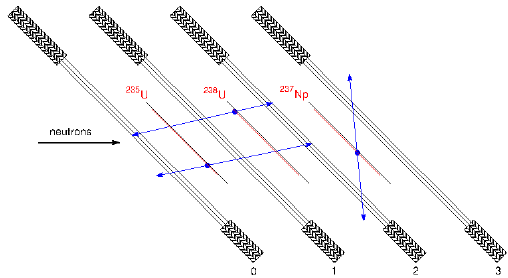
Figure 8: Ensemble of PPAC detectors and samples tilted at 45 ◦ in respect to the neutron beam.